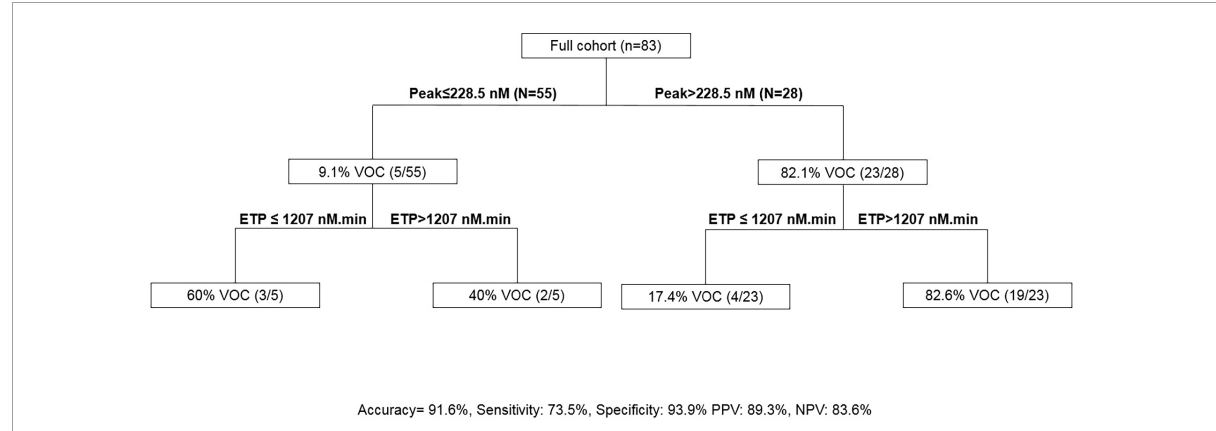
FIGURE4 Calibrated automated thrombography (CAT)-based algorithm to predict VOC. ETP, endogenous thrombin potential; PPV, positive predictive value; NPV, negative predictive value, VOC, vaso-occlusive crisis.